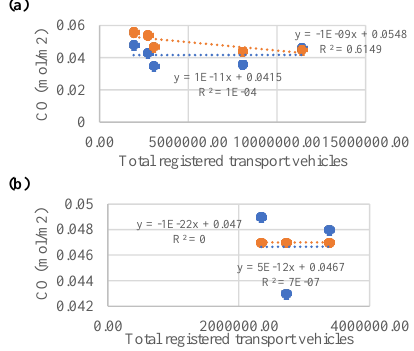
Figure 19. Influence of total registered transport vehicles on